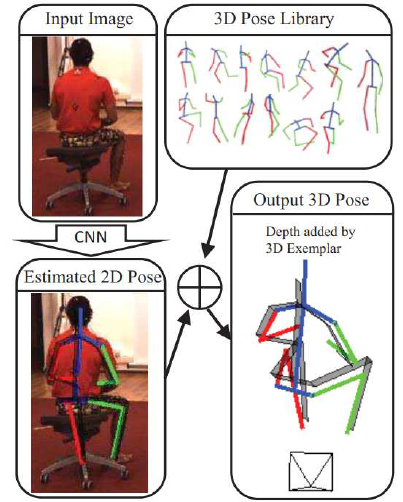
Fig. 2: Illustration of method for 3-D human pose esti- mation [38]: the input is a RGB image, the (cid:28)rst estimate a 2-D pose and then estimate its depth by matching to a library of 3-D poses. The (cid:28)nal prediction is given by the colored skeleton based on the 3-D poses library, while the ground-truth is shown in gray.